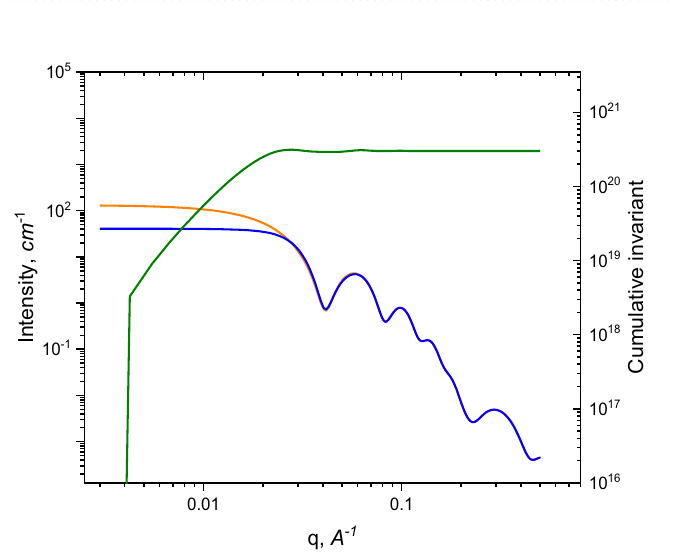
Table 3. List of the parameters used to simulate scattering curve for Pluronic PE10500.